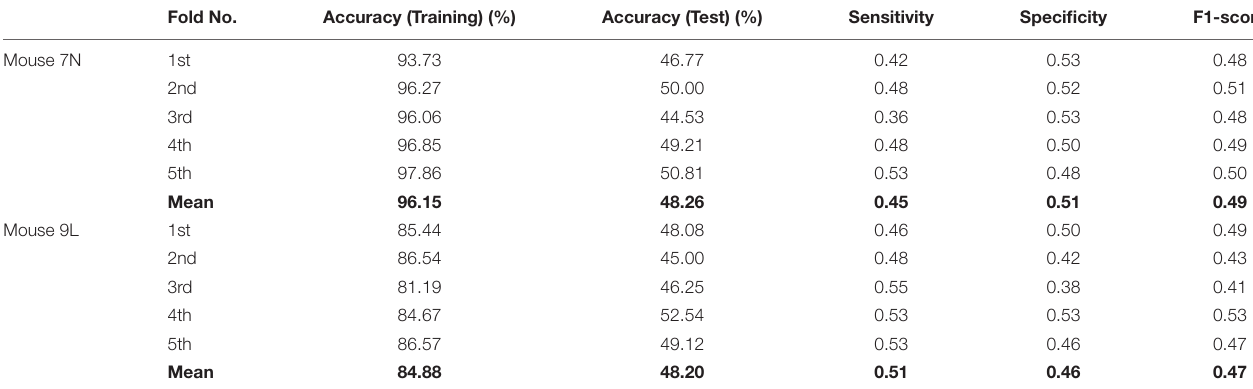
TABLE 4 | Five-fold cross validation results on the prediction of reaching outcome of ITI group for mice 7N and 9L with epoch number equals to 600. Fold No. Accuracy (Training) (%) Accuracy (Test) (%) Sensitivity Specificity F1-score